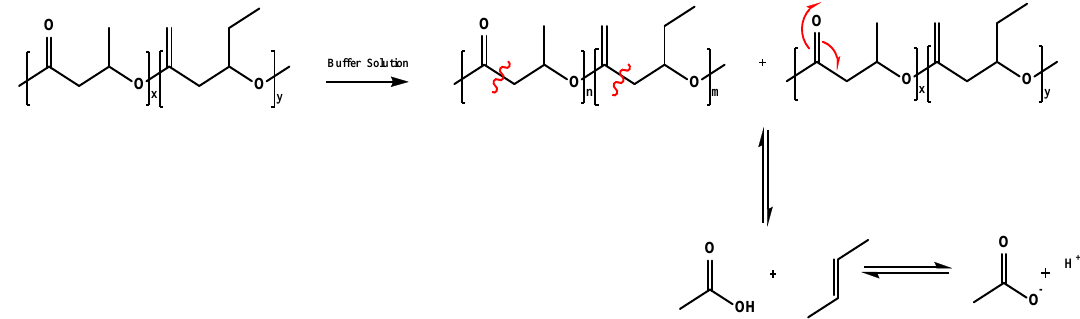
Figure 6. Schematic representation of the PHBV hydrolytic degradation [56].